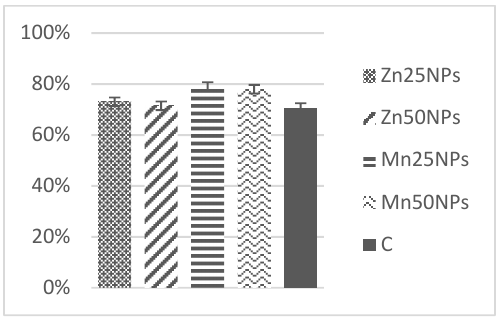
Figure 5. Percentage of turkey sperm with functional mitochondria (%) in samples stored for 24 h with or without (C) the addition of ZnNPs and MnNPs.